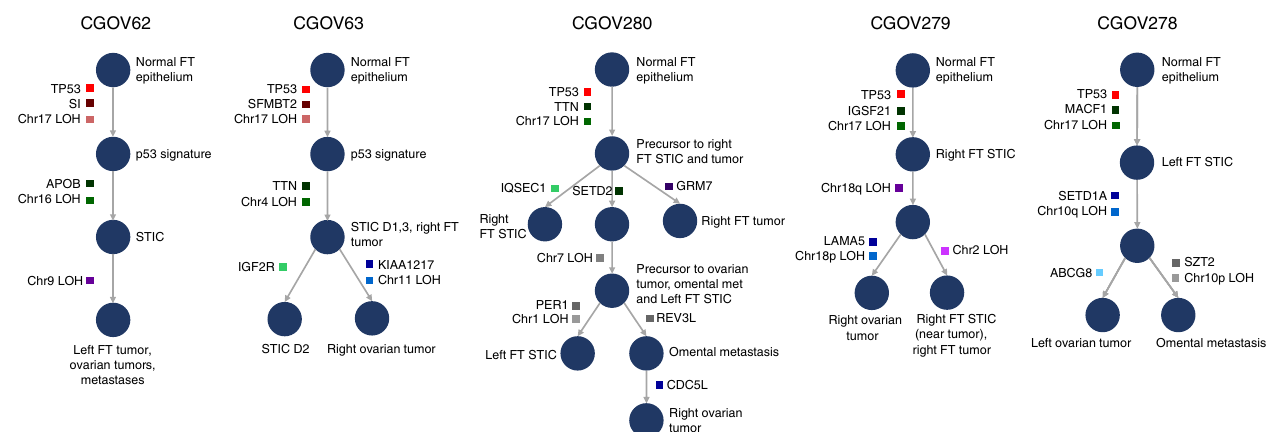
Fig. 4 Schematic of tumor evolution. The history of tumor evolution in each patient is modeled as a subclonal hierarchy inferred from the somatic mutations and large scale genomic regions harboring loss of heterozygosity (LOH features) using the SCHISM framework, and is depicted as a tree. Each tree starts from a root node corresponding to the normal fallopian tube epithelium (germline). In all patients, mutations in TP53 (red boxes) are among the earliest somatic alterations and are ubiquitously present in all tumor samples. Somatic alterations (boxes) are acquired along edges (arrows) of the tree, and example alterations are indicated in each case. Nodes of the tree represent cells whose genotype is described by the presence of somatic mutations and LOH features on the path connecting the node to the root of the tree. Each node is labeled with tumor samples harboring all upstream and lacking any downstream alterations. The trees inferred for all patients support a pattern of evolution with p53 signatures and STIC lesions as early events in tumorigenesis. Mutation clusters and LOH feature groups follow the same color code as Fig.